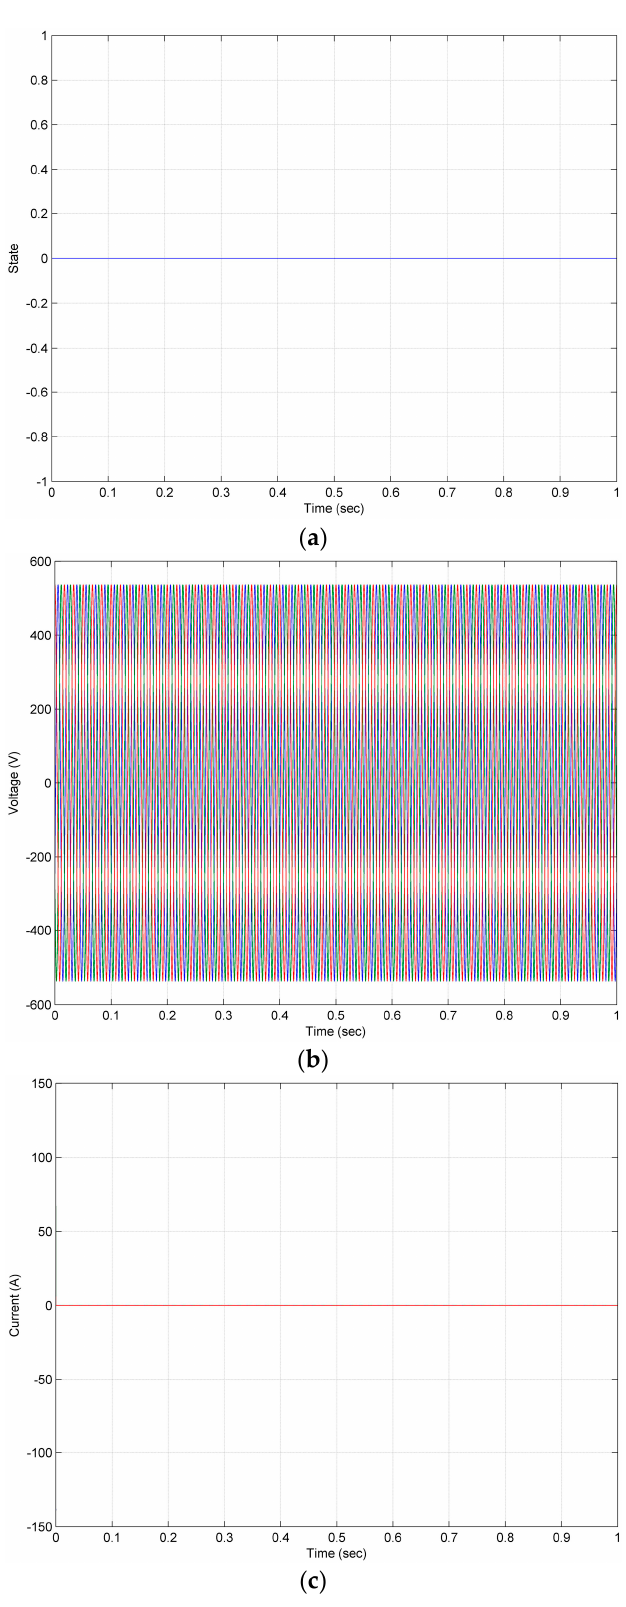
Figure 12. Interactive communication of the agents under grid-connected mode, fault occurrence at Bus 1 and failure trip of CB10.